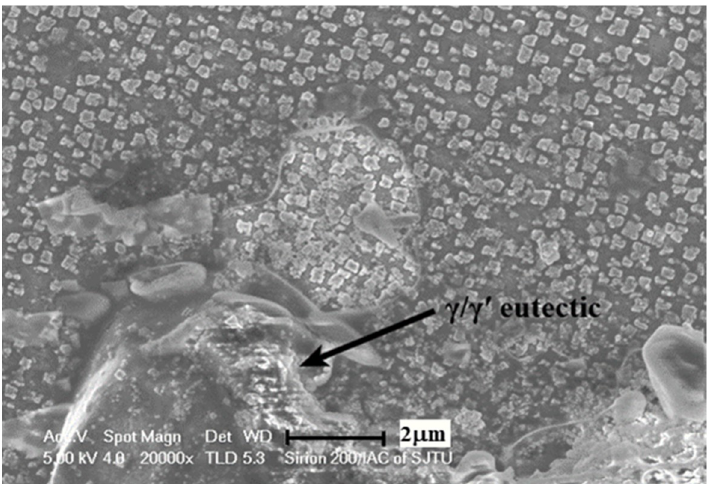
Figure 6. Petal γ/γ′ eutectic phases in the interdendritic area of the DSC sample with a cooling rate of 20 K/min.